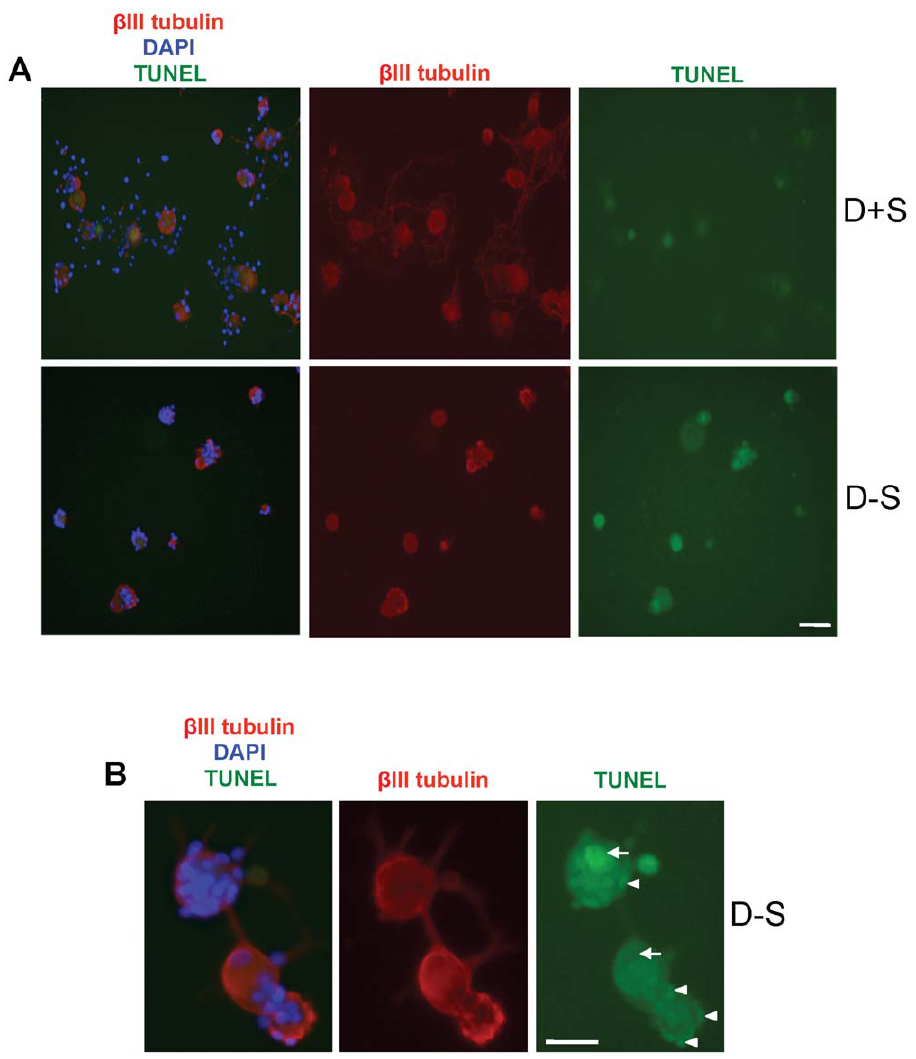
Figure 7. TUNEL staining in 3 day DRG cultures grown in DMEM in the presence of serum (D + S) and after serum withdrawal (D 2 S). A , TUNEL + DRGN in the presence of serum (D + S) or after serum withdrawal (D 2 S). B , DRGN grown in the absence of serum (D 2 S) demonstrating TUNEL + nuclei of both DRGN (arrow) and satellite cells (arrowheads). Scale bars in A and B =50 m m.